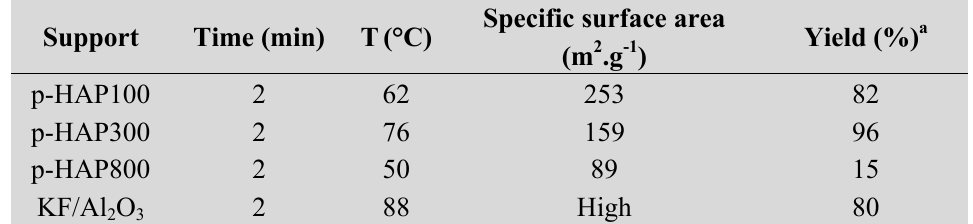
Table 2. The specific surface area effect of supports on Knoevenagel condensation involving 4 nitrobenzaldehyde ( 1b ) and 2a under microwave irradiation.